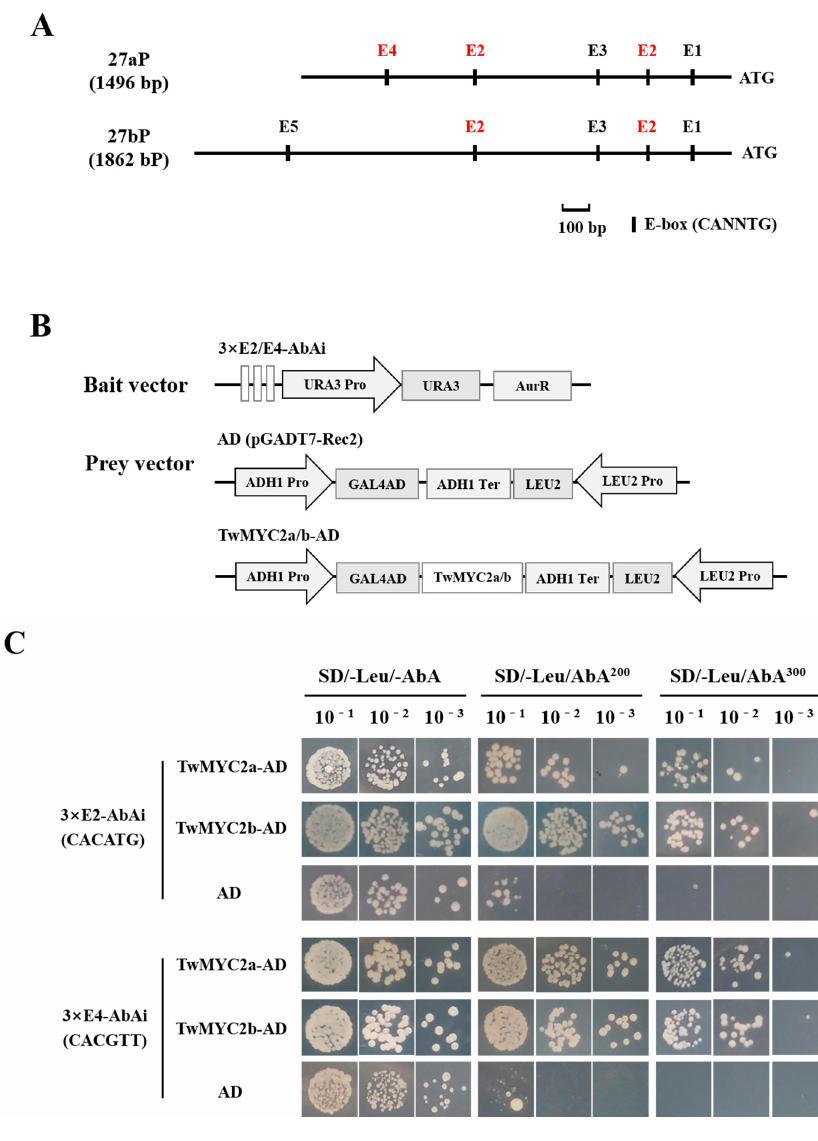
Figure 2. TwMYC2a/b could bind to the E-box (CACATG) and T/G-box (CACGTT) in yeast cells. ( A ) Schematic diagram of the different E-box motifs present in the TwTPS27a and TwTPS27b promoters. These motifs are E1 (CAGATG), E2 (CACATG), E3 (CAAATG), E4 (CACGTT, called T/G-box), and E5 (CAATTG), respectively. ATG, the start codon. ( B ) Schematic diagrams of the bait and prey vectors used for yeast one-hybrid (Y1H) assays. The triple repeated sequences of E-box (E2, CACATG) and T/G-box (E4, CACGTT) were synthesized and ligated into pAbAi, while the full-length coding sequences of TwMYC2a and TwMYC2b were separately fused with GAL4 AD in pGADT7-Rec2. ( C ) Y1H assays showing that TwMYC2a/b could bind to the E-box (E2, CACATG) and T/G-box (E4, CACGTT) present in the TwTPS27a/b promoters, based on the ability of the transformed Y1HGold yeast cells to grow on SD/ − Leu/AbA 200 and SD/ − Leu/AbA 300 medium in the gradient dilution (1/10, 1/100, 1/1000). The transformants grown on SD/ − Leu/ − AbA plate were used as positive controls for transformants growth. Positive transformants were confirmed by spotting yeast cells onto agar medium of SD/ − Leu with 200 and 300 ng/mL AbA. These assays were repeated three times with similar